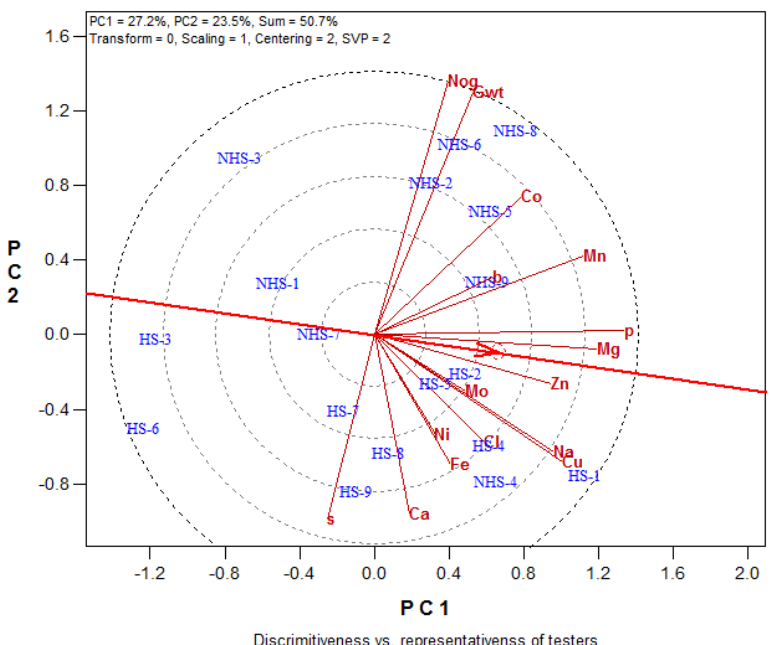
Figure 2. The discriminatory and representative abilities of the attributes. HS—heat-stress en- vironment, NHS—non-heat-stressed environment, 1—WE3128 with MF, 2—WE3128 with MPM, 3—WE3128 with PM, 4—WE5323 with MF, 5—WE5323 with MPM, 6—WE5323 with PM, 7—ZM1523 with MF, 8—ZM1523 with MPM, 9—ZM1523 with PM, GWt—grain weight, and NoG—number of grain.